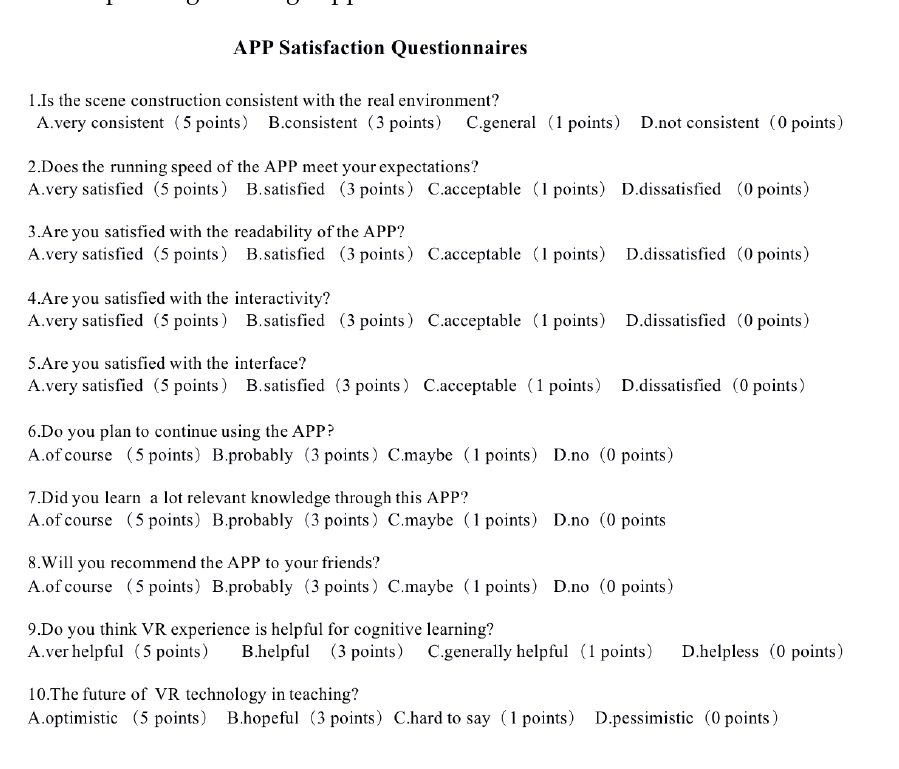
Figure 10. Satisfaction